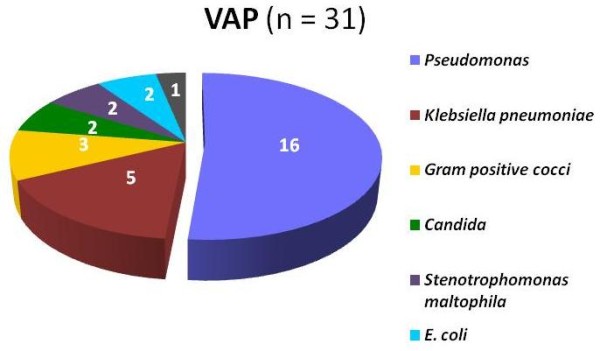
Pathogens isolated in ICU patients with VAP. Gram negative predominated in VAP. Only one S aureus was isolated.